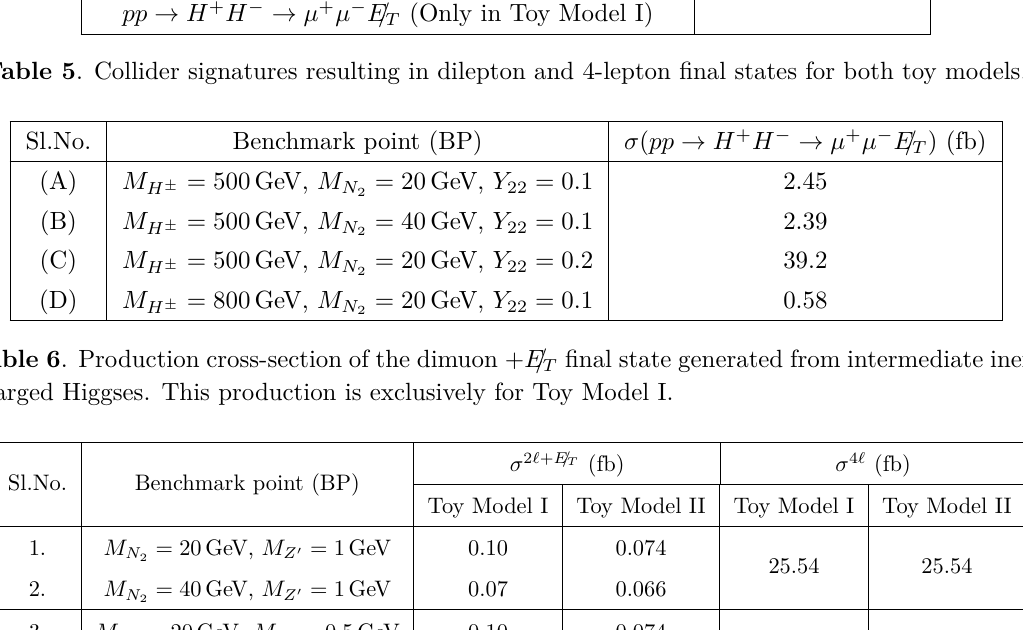
sin α for large tan β . Once again the conclusions are not affected significantly by the DM mass. Also, we have noted that for values like tan β = 2 and s branching fraction B ( h → µe ) ≤ 0 . 4% for Y ‘